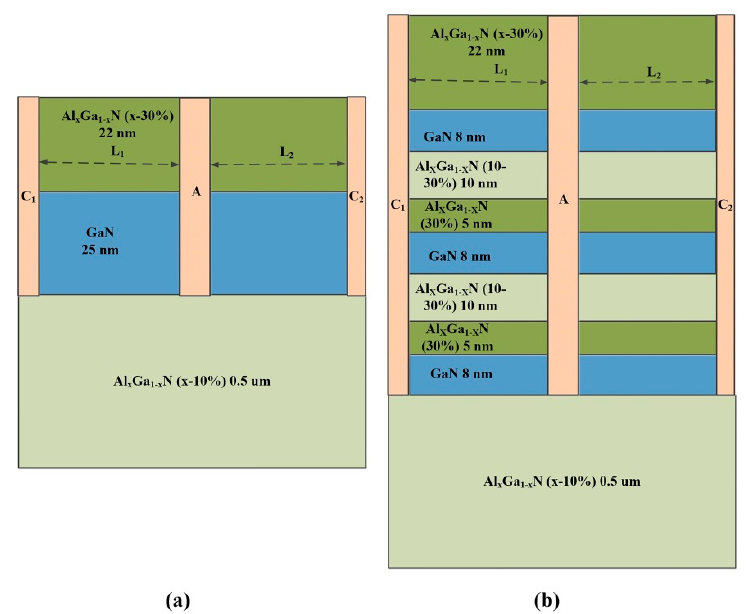
Figure 1. The cross-section device structure of the AlGaN/GaN planar Gunn diode with trench anode electrode: ( a ) one 2D electron-gas (2DEG)-channel diode; ( b ) triple-2DEG-channel diode.